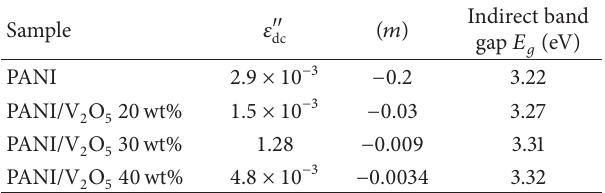
O composites (different weight %). 2 5